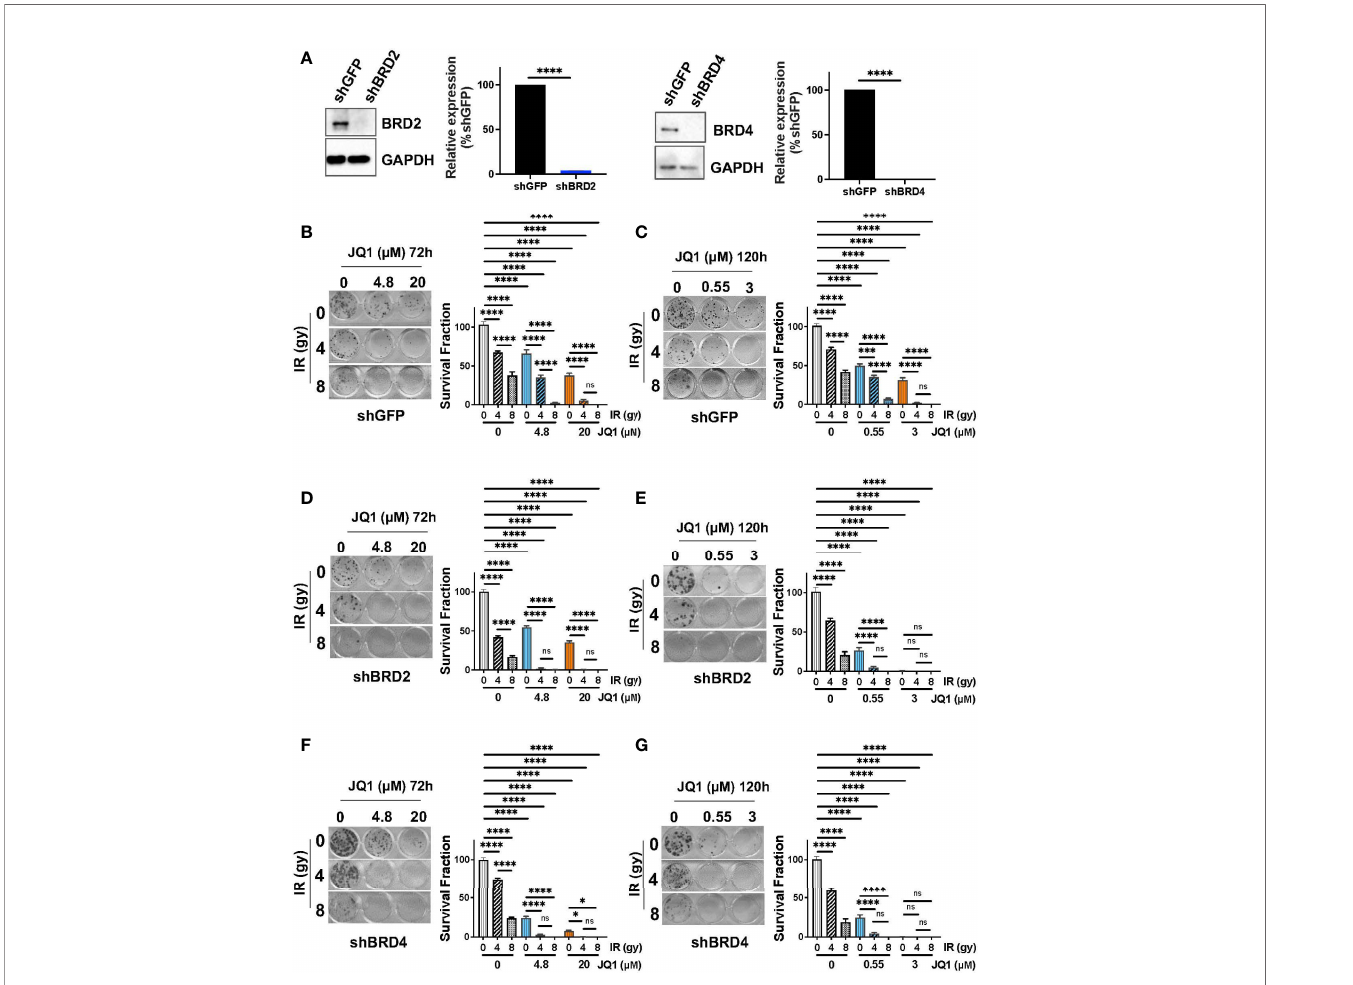
FIGURE 4 | Downregulation of BRD2 or BRD4 enhances sensitivity to JQ1 + IR. (A) Levels of BRD2 and BRD4 protein were lower in Panc1 cells transfected with shBRD2 or shBRD4 than in shGFP control transfectants. Quantitation of expression level was done as in Materials and Methods. ****p<0.0001. (B, C) Images of representative clonogenic assays showing colonies for shGFP transfectants exposed to JQ1 for (B) 72 hours or (C) 120 hours ± IR or for (D, E) shBRD2 transfectants or for (F, G) shBRD4 transfectants. Average survival fraction ± SEM is shown to the right of each image as a bar graph. Quantitation was done as in Materials and Methods. *p < 005, ***p < 0.001, ****p < 0.0001. ns, not signi fi